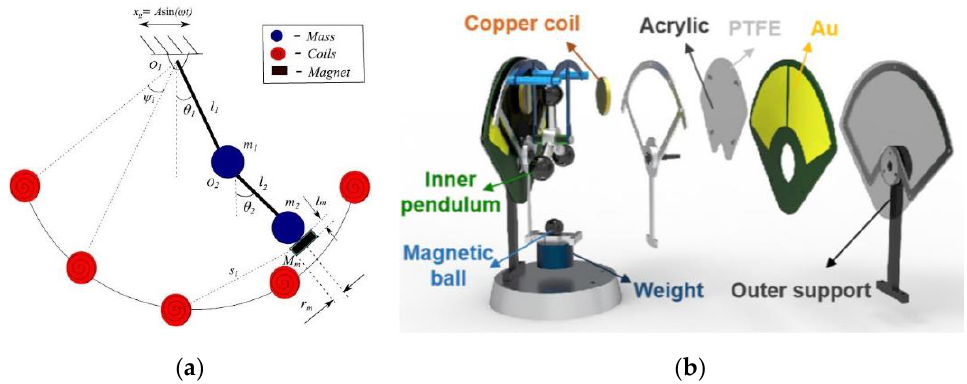
Figure 17. ( a ) Electromagnetic energy harvester under base excitation [116]. Reprinted with permission from Ref. [116]. Copyright 2019, Elsevier. ( b ) Triboelectric – electromagnetic hybridized energy harvester [118]. Adapted with permission from Ref. [118]. Copyright 2019, Elsevier.